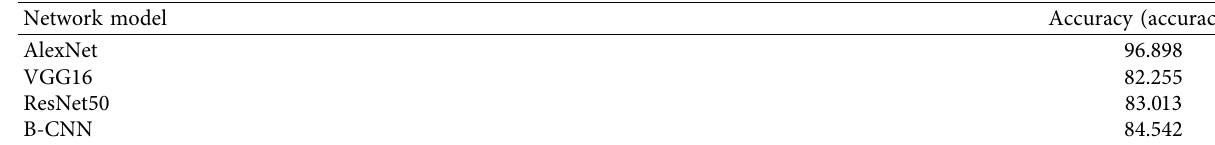
Table 8: Accuracy of the network model.